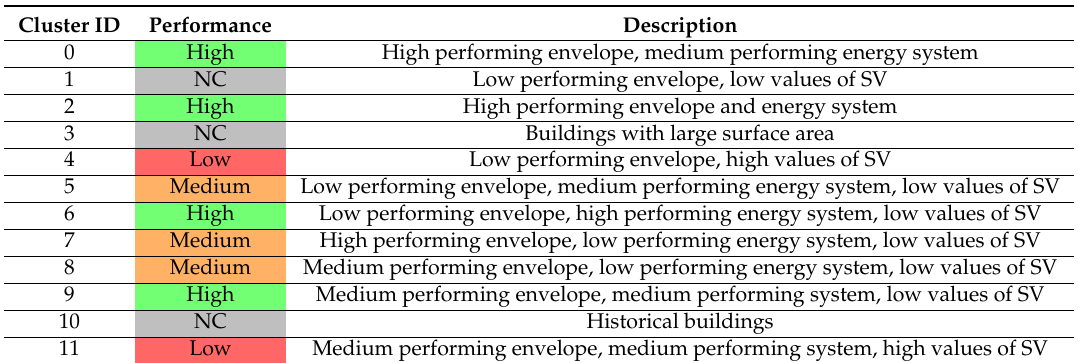
Table 4. Semi-supervised data